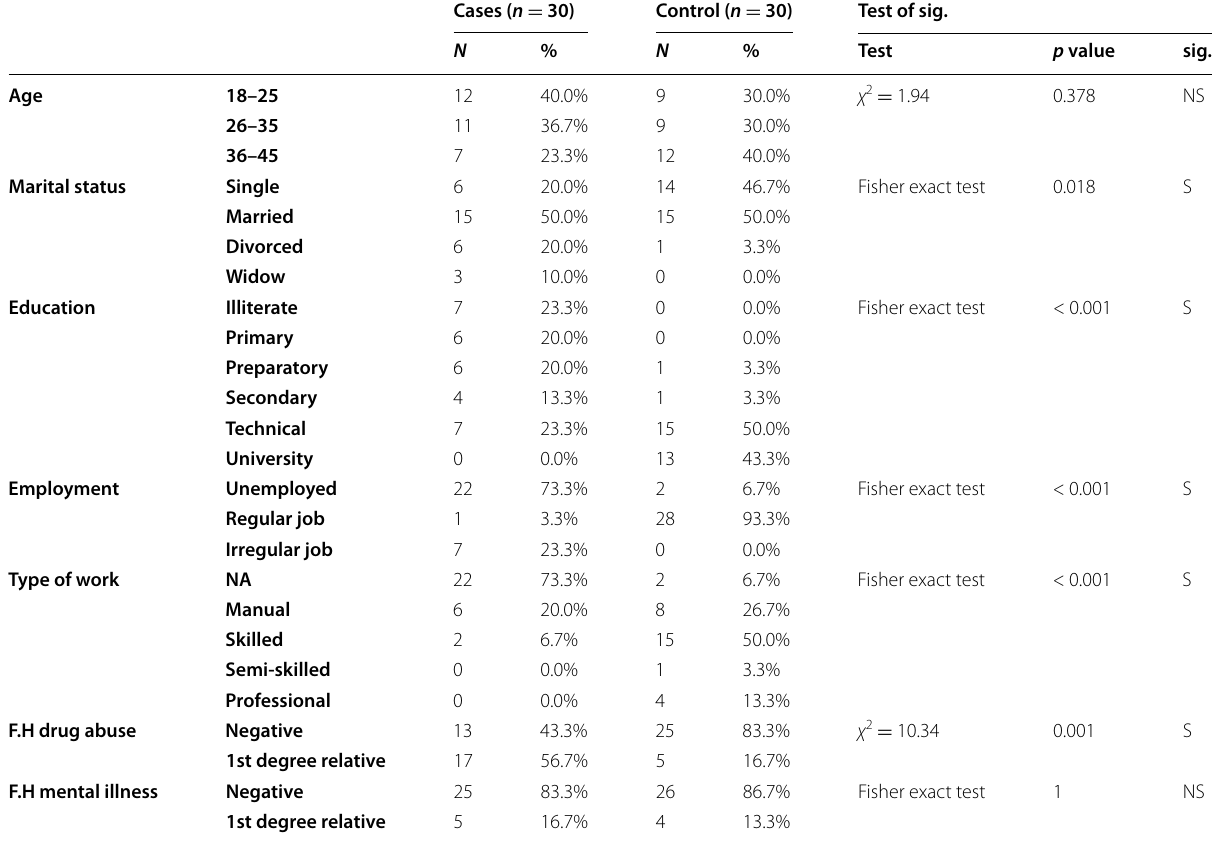
Table 1 Sociodemographic data of cases and controls